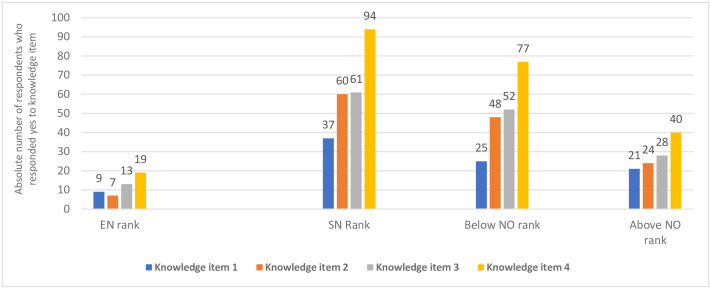
Staff knowledge on basic wound dressing standard policy protocols (n = 140).Field Data (2019); Knowledge factor 1 (Staff who knew to the use of methylated spirit and povidone iodine for surgical wound care), Knowledge factor 2 (Staff who knew the use of normal saline and povidone iodine for septic wound care), Knowledge factor 3 (Staff who knew when a trolley is bathed before wound care), Knowledge factor 4 (Staff who knew they have to wash their hands at least two-times before wound dressing); SN (Staff Nurse); NO+ (Nursing Officer or higher professional rank); NO- (Below the ranks of a Nursing Officer in professional rank); EN (Enrolled Nurses).